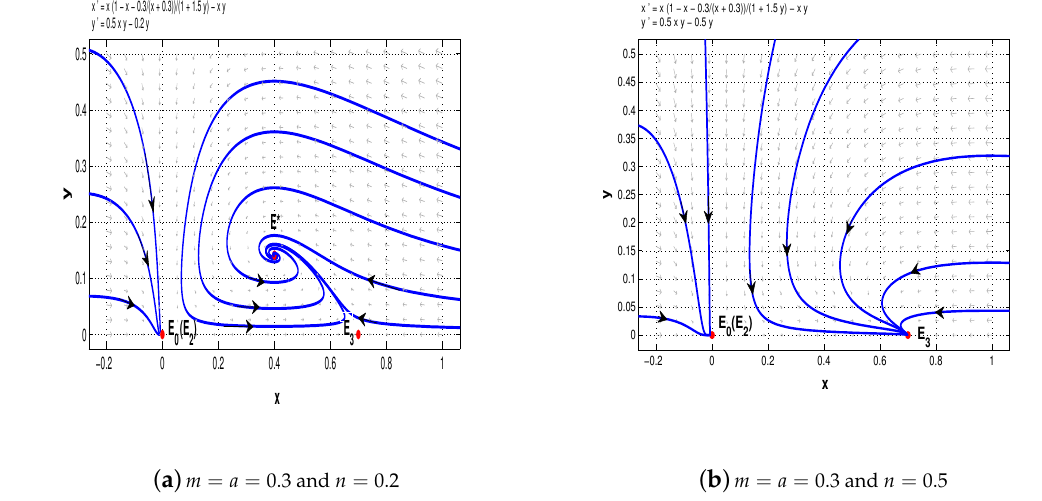
Figure 6. ( a ) With m = a = 0.3 and n = 0.2, E 0 is a saddle-node, E 3 is a saddle point, and E ∗ is a stable node. ( b ) With m = a = 0.3 and n = 0.5, E 0 is a saddle node and E 3 is a stable